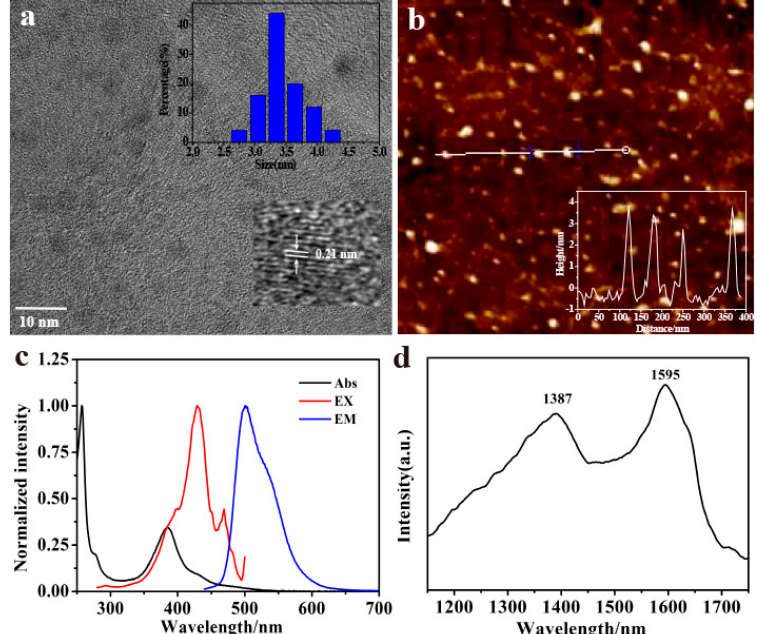
Figure 1. ( a ) TEM images (inset: particle size distribution and HRTEM images). ( b ) AFM images (inset: the height profile). ( c ) Normalized UV-vis absorption spectra, fluorescent excitation, and emission spectra of P-doped CQDs. ( d ) The Raman spectra of P-doped CQDs.